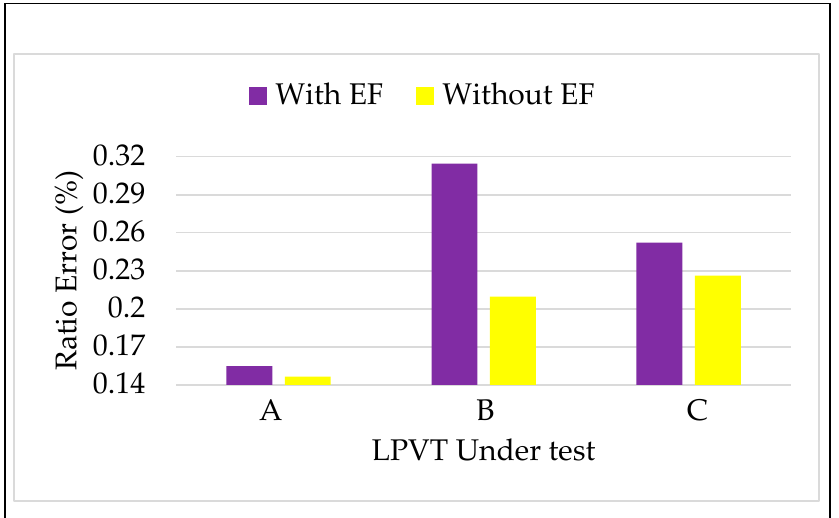
Figure 7. Ratio error vs. electric field for the three LPVTs under test.